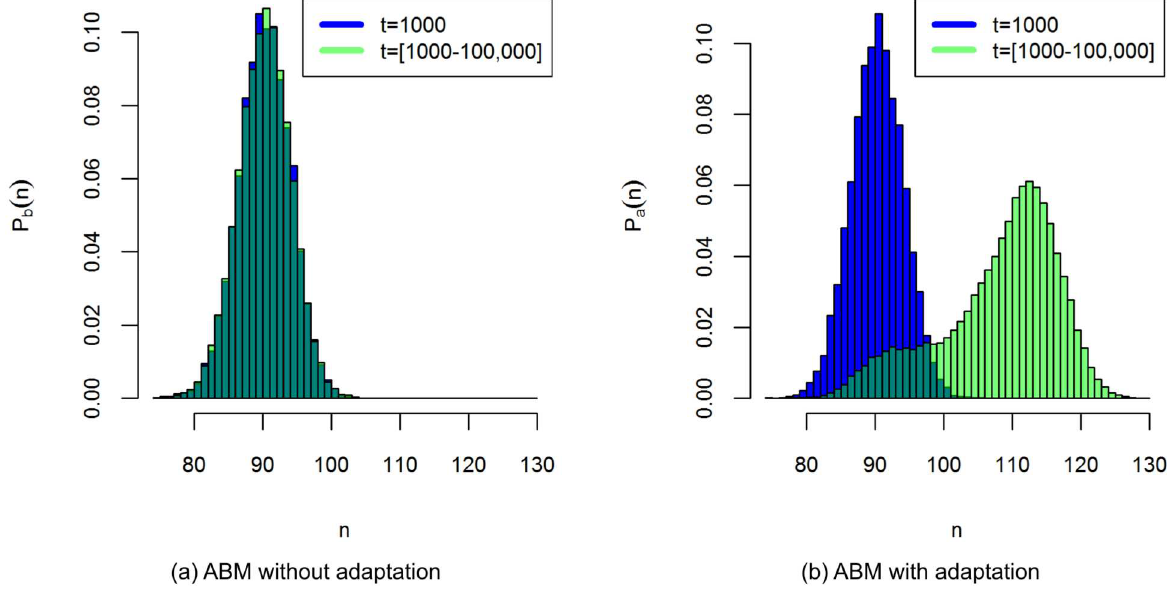
Fig 6. Time-averaged histograms of the number of agents ( n ). The blue histograms are measuredover 10,000replicateruns at t = 1000, and the green histograms over the time-steps of a singlemodel run between t = 1000 and t = 100,000. All parameters are at their default values. Fig 6a indicatesthat the ABM without adaptation is ergodic, and Fig 6b indicates that the ABM with adaptationis not